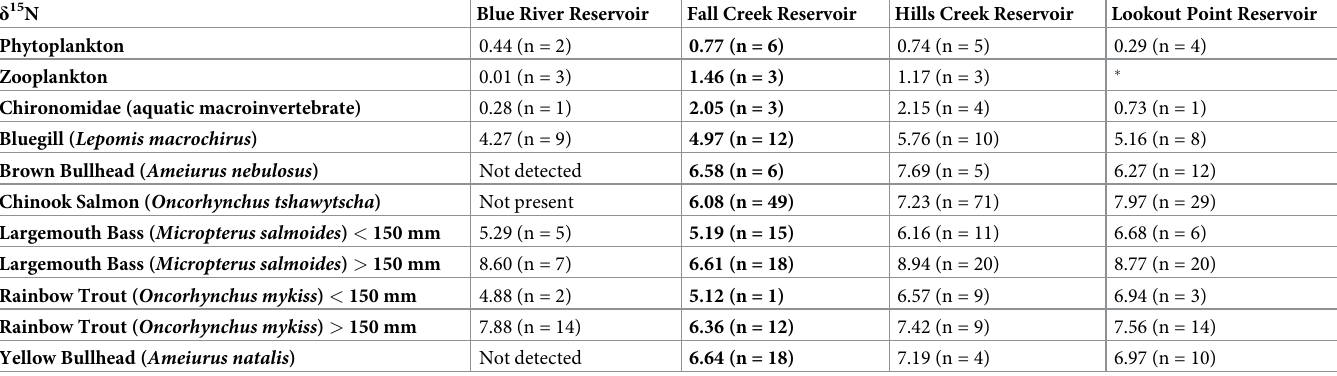
Table 1. δ 15 N values for other trophic levels and fish species in the four study reservoirs. Note that phyto- and zoo-plankton samples were bulk samples and likely represent a range of taxa. δ 15